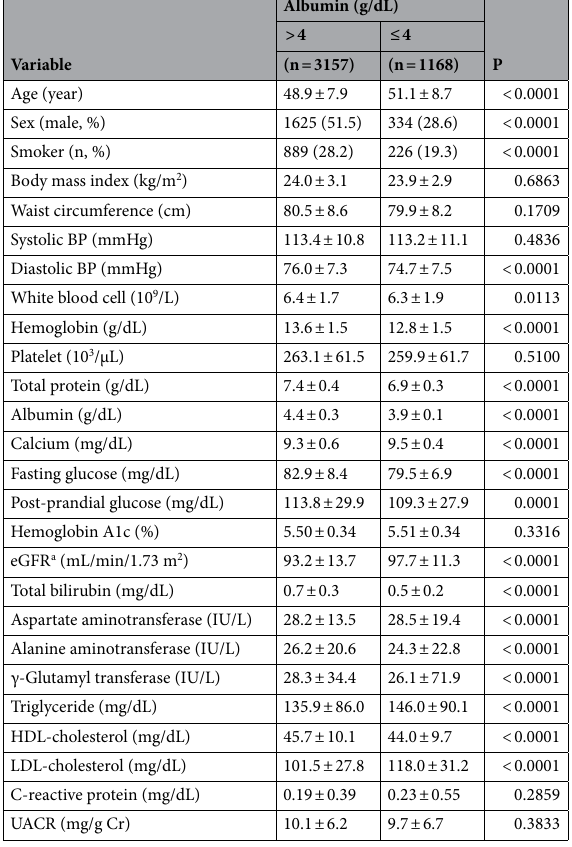
Table 1. Baseline characteristics grouped by serum albumin concentration. Results are expressed as the mean ± standard deviation or as frequencies (and proportions). BP, blood pressure; eGFR, estimated glomerular filtration rate; HDL, high-density lipoprotein; LDL, low-density lipoprotein; UACR, urine albumin/ creatinine ratio; Cr, creatinine. a Estimated using the Chronic Kidney Disease Epidemiology Collaboration